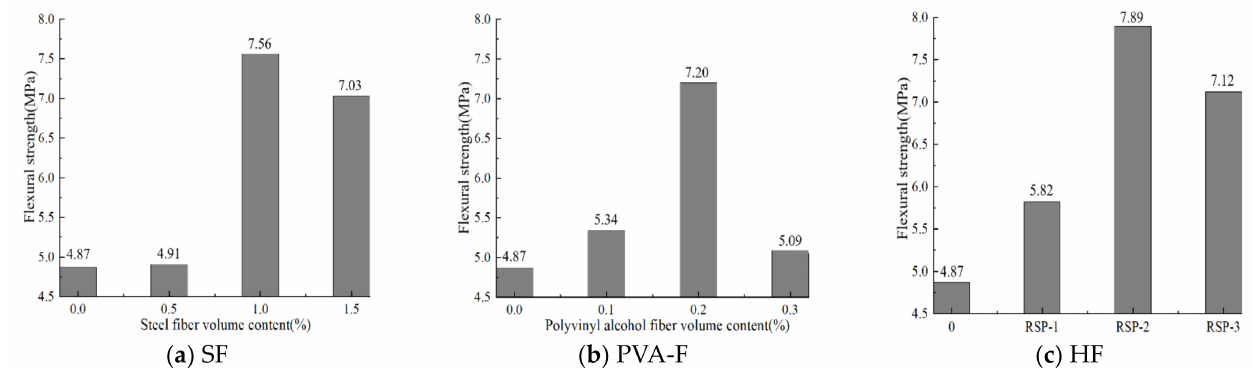
Figure 11. Flexural strength of fibre-reinforced recycled